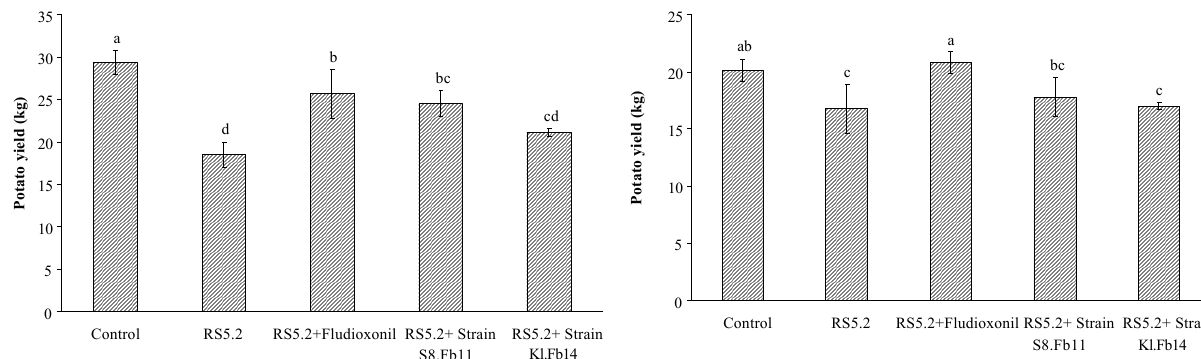
Figure 1. Mean tuber yields (kg/10 m row) from the potato cultivars ‘Spunta’ (A) or ‘Nicola’ (B) inoculated with Rhizoctonia solani isolate RS5.2 and treated with a fungicide (fludioxonil) or two different bacterial strains (S8.Fb11 or K1.Fb14), applied in a field trial. Means accompanied by different letters are significantly different according to Duncan’s multiple range test at P <0.05.